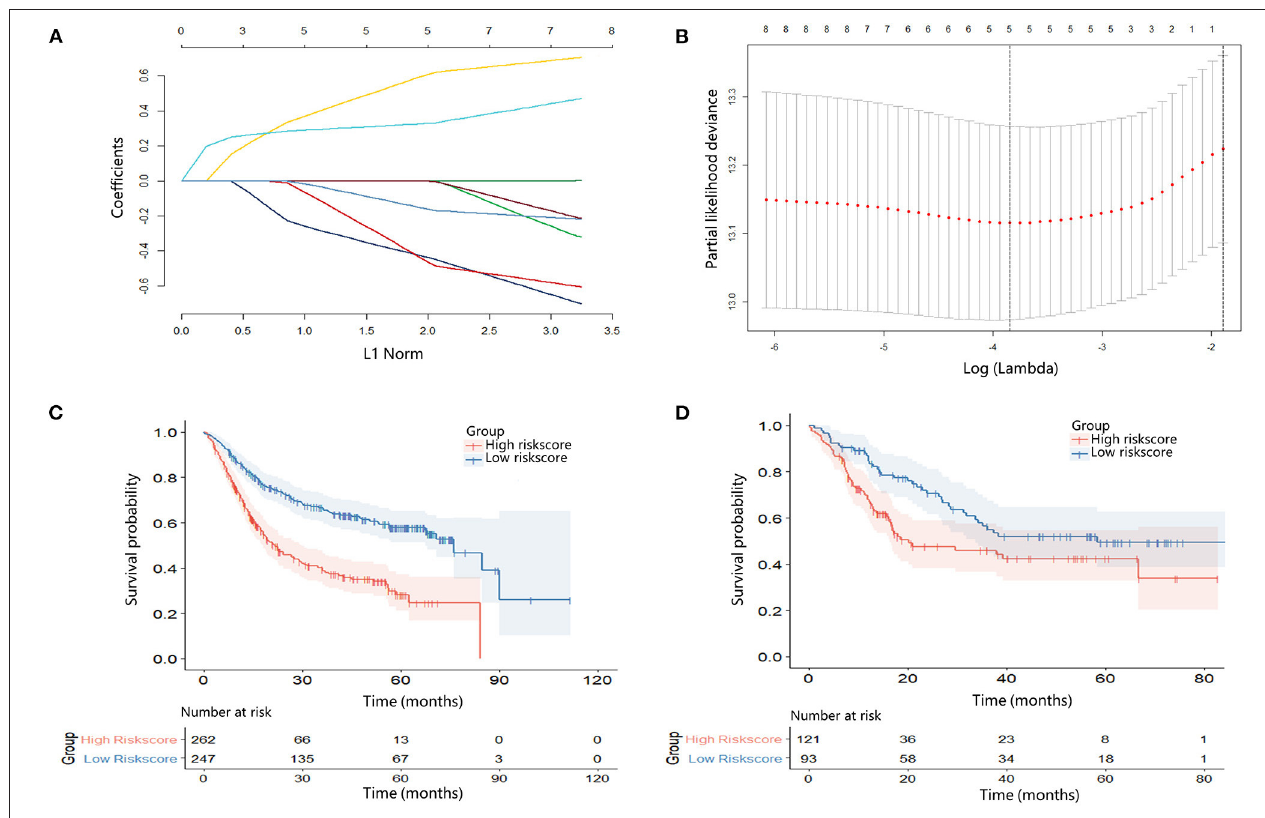
FIGURE 2 | (A) Least absolute shrinkage and selection operator (LASSO) coefficient profiles of eight hematological indicators. (B) 10-fold cross-validation for tuning parameter selection in the LASSO model. (C) Kaplan–Meier survival curve according to the inflammation-nutrition score in the primary cohort. High inflammation-nutrition score, n = 262; low inflammation-nutrition score, n = 247. (D) Kaplan–Meier survival curve according to the inflammation-nutrition score in the validation cohort. High inflammation-nutrition score, n = 121; low inflammation-nutrition score, n = 93.